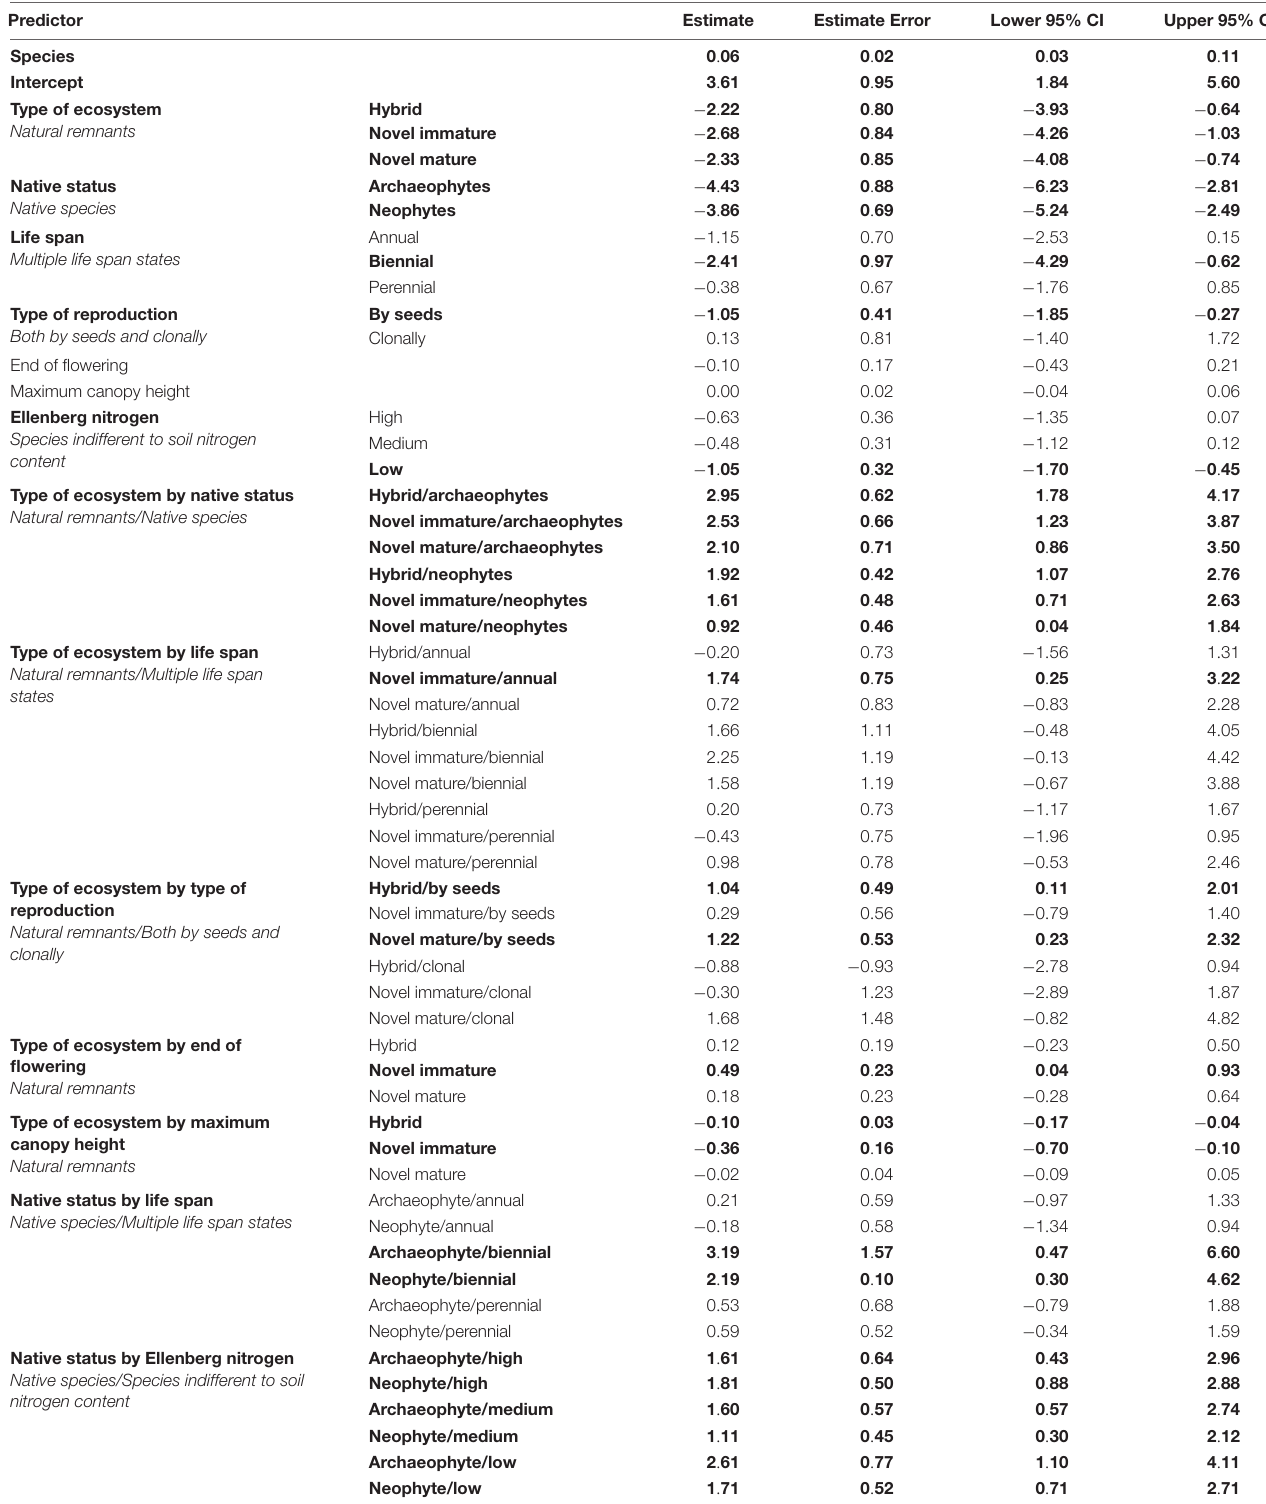
TABLE 3 | Result of the final full model (as result of stepwise backward selection) explaining the establishment of vascular plant species across the city of Berlin, Germany with interactions of type of ecosystem by native status, type of ecosystem by traits, and native status by traits as fixed predictors, together with species identity as a random predictor and a covariance matrix of species based on phylogenetic relationships (summed as predictor